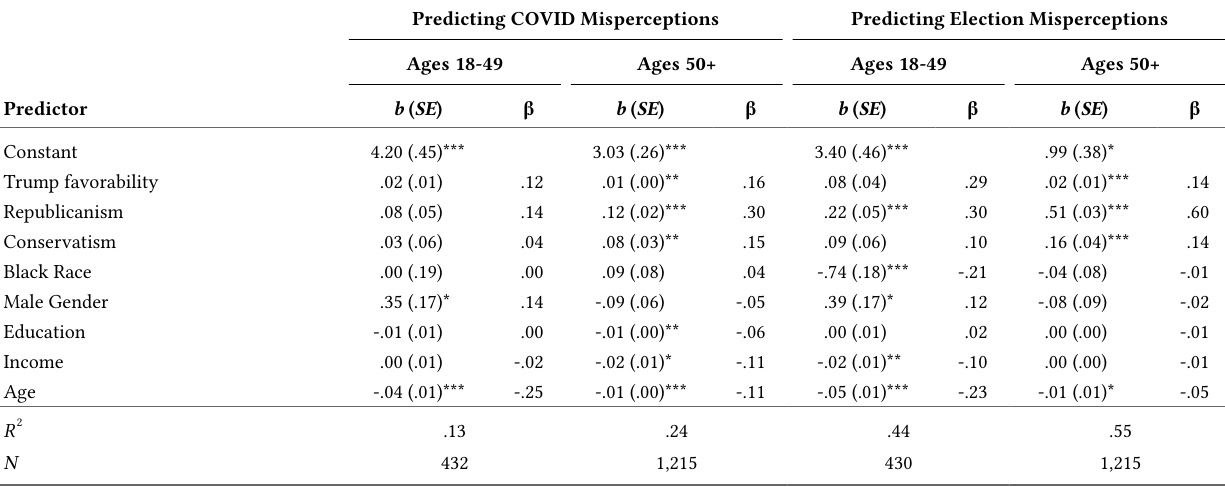
Regressions Predicting Misperceptions of COVID and the 2020 Election as a Function of Political and Sociodemographic Variables Within Each Age Sample Predicting COVID